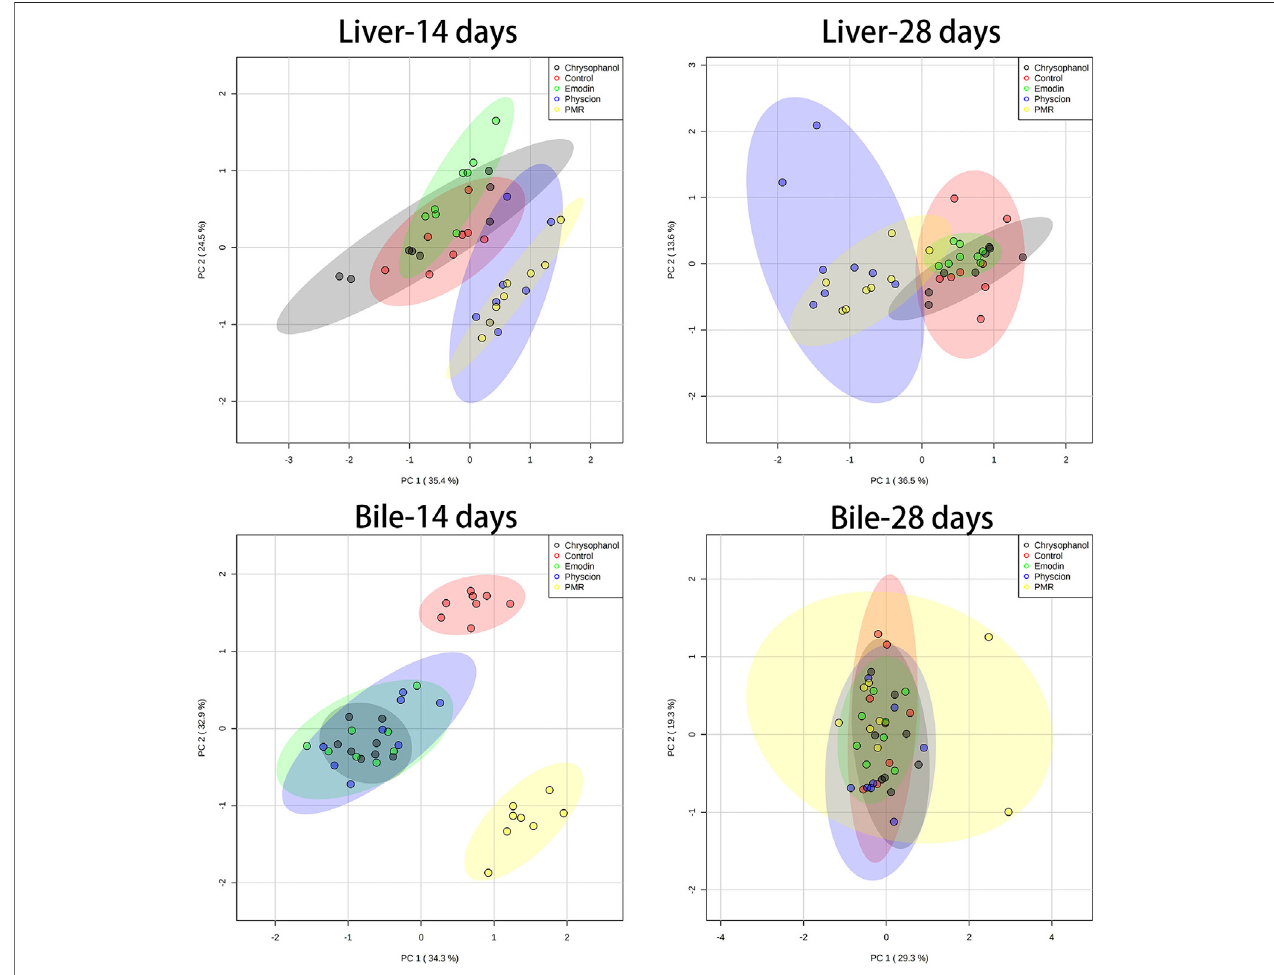
FIGURE5| PCAresultsbasedonthequantitativeanalysisoftheBAsinthemouseliverandbilefromdifferentgroupsofmicefollowing14-or28-daytreatmentwith anthraquinones or PMR extract.